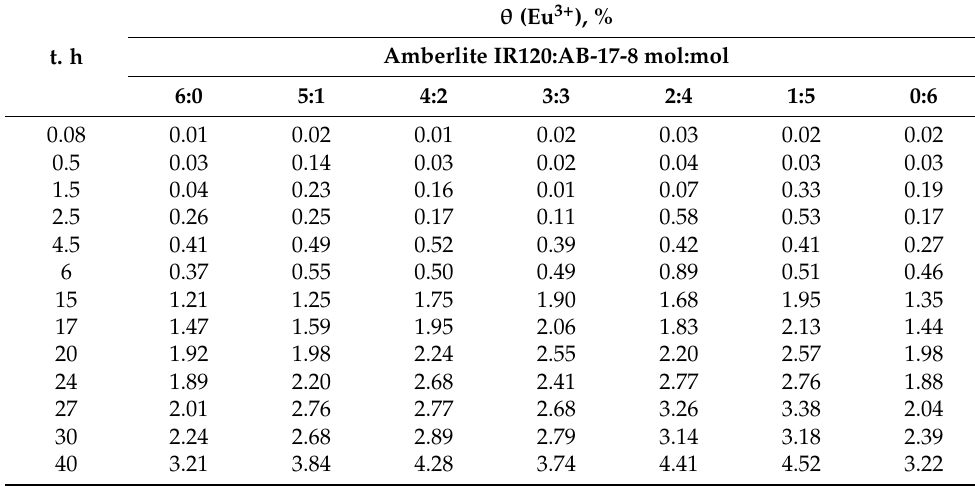
Table 2. Polymer chain binding degree.